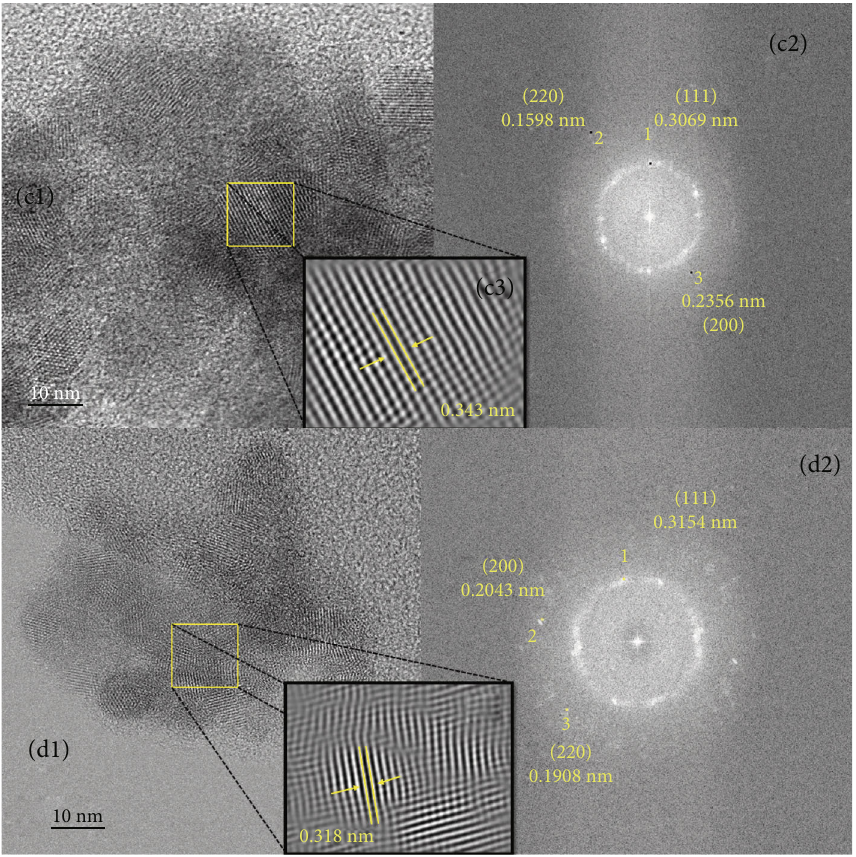
Figure 5: HRTEM pattern of Zn Cd S solid solutions in (c1) is synthetized by coprecipitation and in (d1) is assisted with sonochemistry. 0.2 0.8 (c2) and (d2) The selected portion shows the Fourier transformed from (c1) and (d1); and (c3) and (d3) show the interplanar spacing between